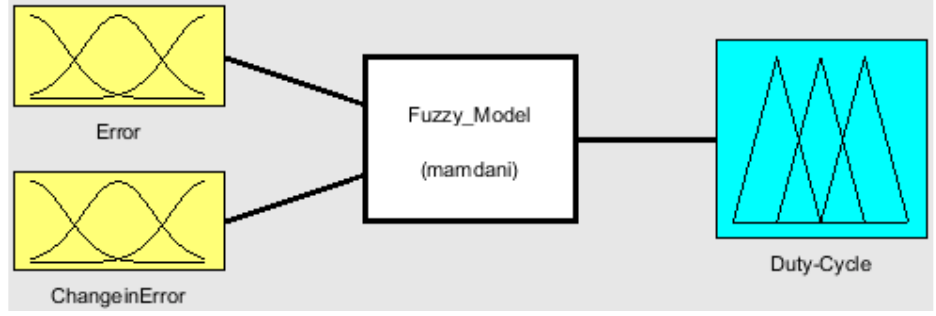
Figure 7. Fuzzy logic approach.